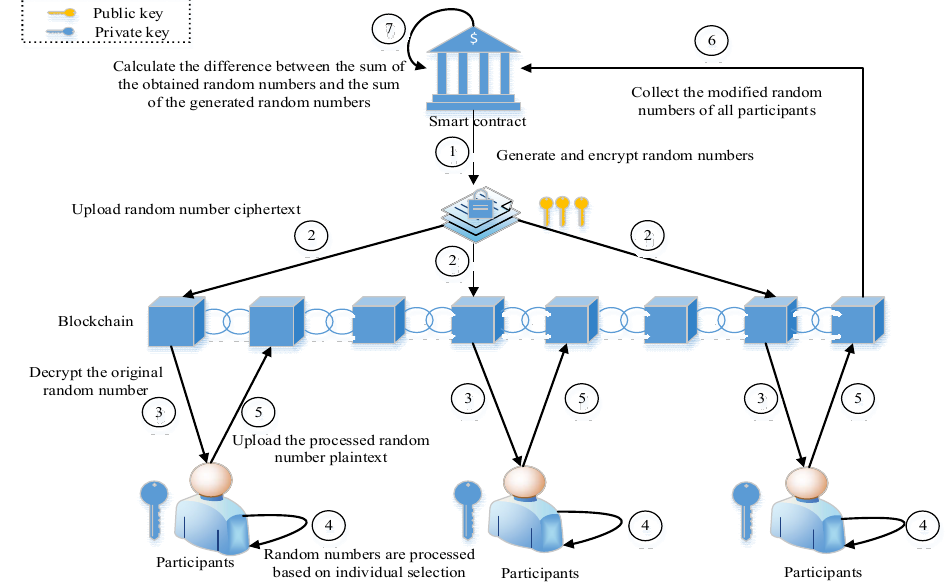
Figure 3. A flowchart of multiparty security computation technique.